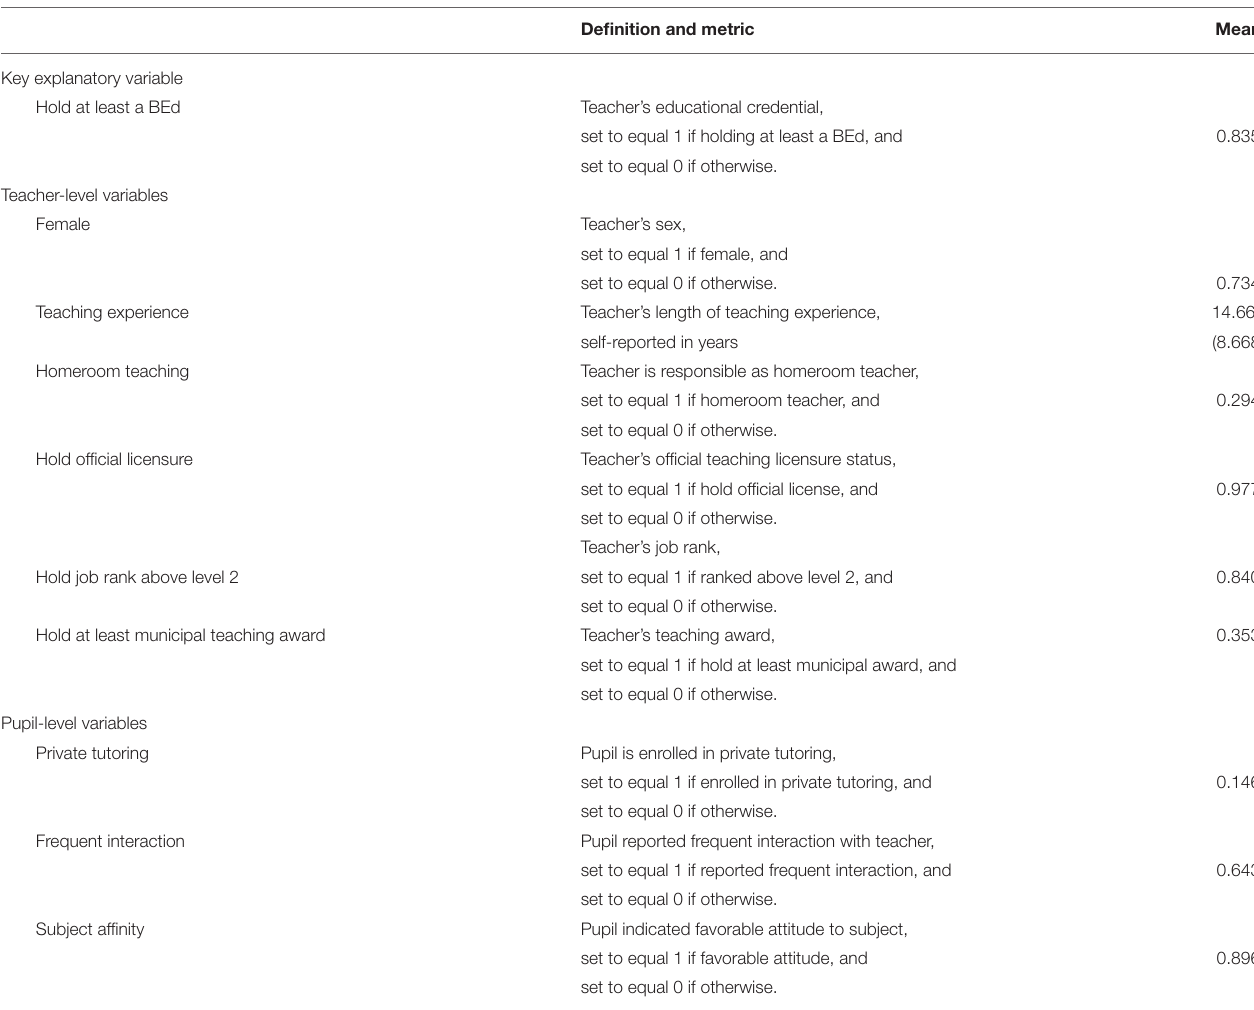
TABLE 1 | Sample descriptive statistics information ( n =